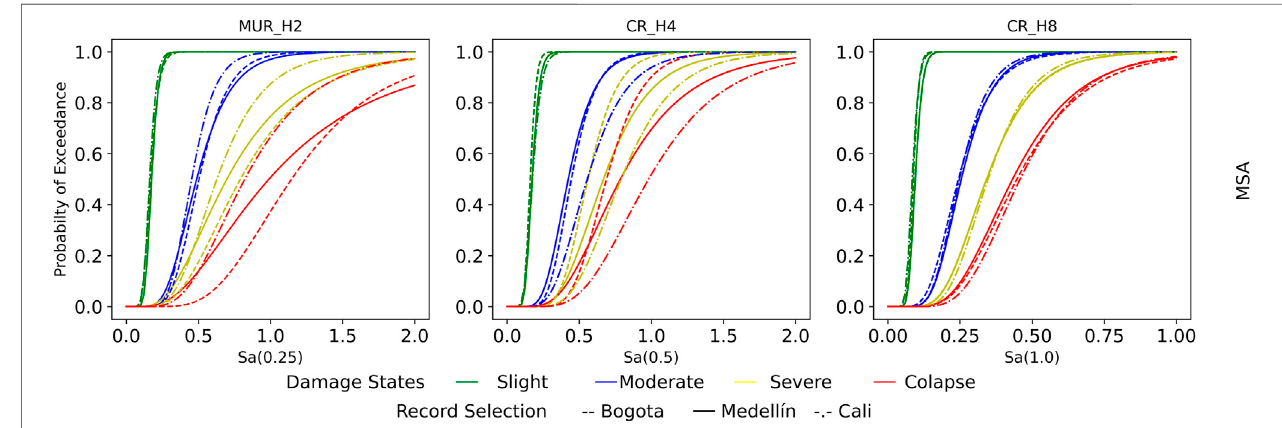
FIGURE10| Comparison oftheMSAfragilitycurvesbetweenthethree cities:Bogotá(dashedline), Medellín (continuousline),and Cali(dotted-dashed line) forthe three-building types: two-story unreinforced masonry (left), four-story reinforced concrete (center), and eight-story reinforced concrete